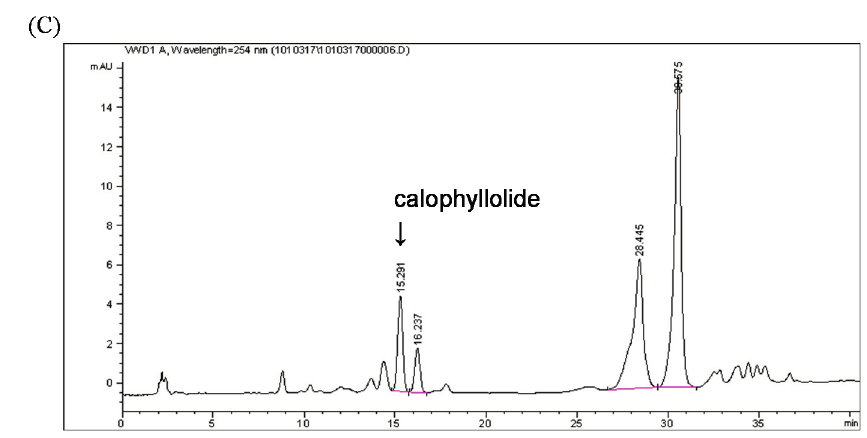
Figure 2. HPLC chromatograms of the ( A ) peel; ( B ) shell; and ( C ) nut of Calophyllum inophyllum , recorded at 254 nm. The retention time of calophyllolide is 15 min. The calophyllolide content in nuts at different stages of maturity was analyzed by HPLC. The calophyllolide content in dried nuts was approximately 2.3 mg·g − 1 in samples collected in September, whereas in samples collected in December, the calophyllolide content decreased to 1.6 mg·g − 1 . Our results showed that the greater the maturity of the fruit, the less calophyllolide is found in nuts of C. inophyllum (Figure 3).